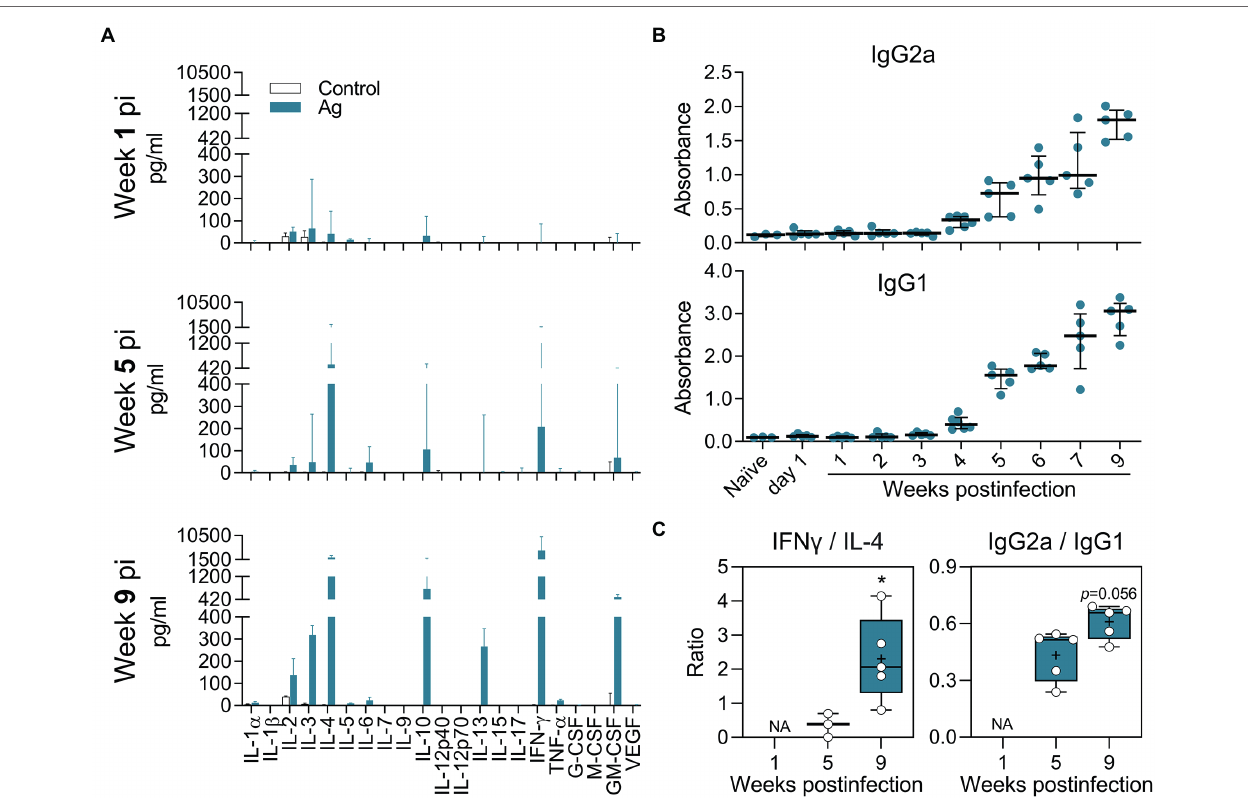
FIGURE 4 | Antigen-specific cytokine and antibody response of L(V)p -infected BALB/c mice. Draining LNs from L(V)p -infected mice were obtained at the indicated timepoints to prepare cell suspensions. Cells were cultured in the absence (Control) or presence (Ag) of L(V)p total lysate. The concentration of the indicated cytokine secreted by dLN cells was determined by a multi-analyte Luminex platform and graphed as the median ± interquartile range (A) . Serum samples were also used to quantify the antigen-specific IgG1 and IgG2a response by ELISA (B) . Ab levels in individual mice are shown and the bars are the median ± interquartile range. IFN γ /IL-4 and IgG2a/IgG1 ratios were calculated and graphed as “box and whiskers” plots (C) . IFN γ /IL-13 and IFN γ /(IL-4 + IL-13) ratios exhibited a similar pattern to that presented in (C) . NA: not applicable. pi: postinfection. n = 3–6 mice/group. * p < 0.05 (Mann–Whitney U -test in (C) comparing week 5 vs.